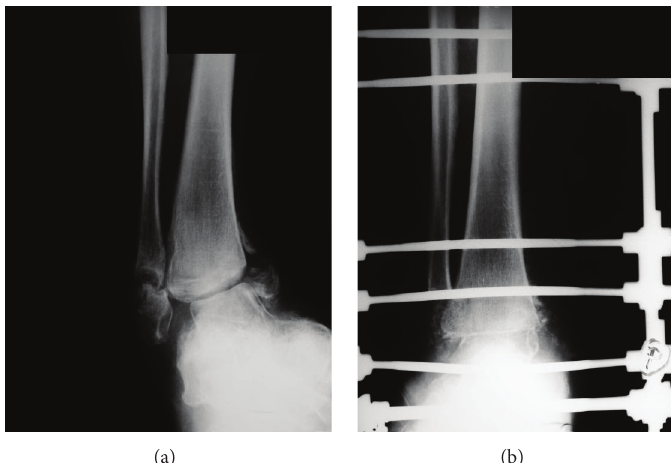
Figure 6: (a) AP X-ray image of the right ankle: inveterate neuropathic fractures of both malleoli. (b) A primary arthrodesis using an external fixation carried out.